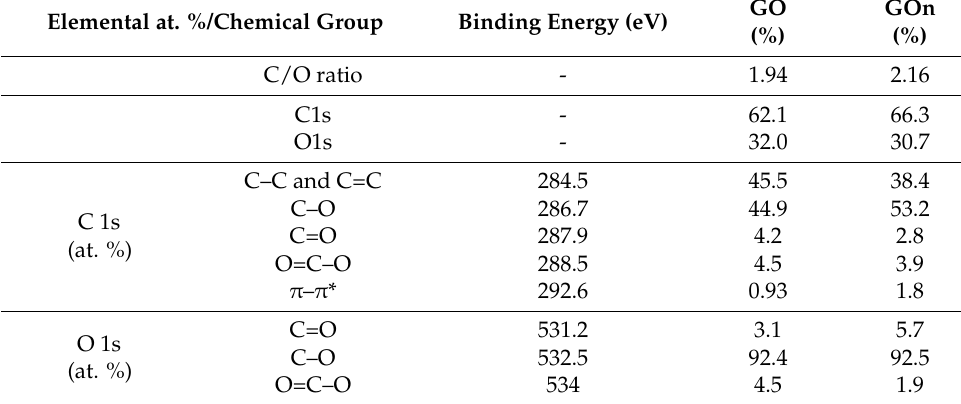
Table 2. Atomic composition of GO and GOn and content of C1s and O1s chemical functional groups resulting from XPS spectra